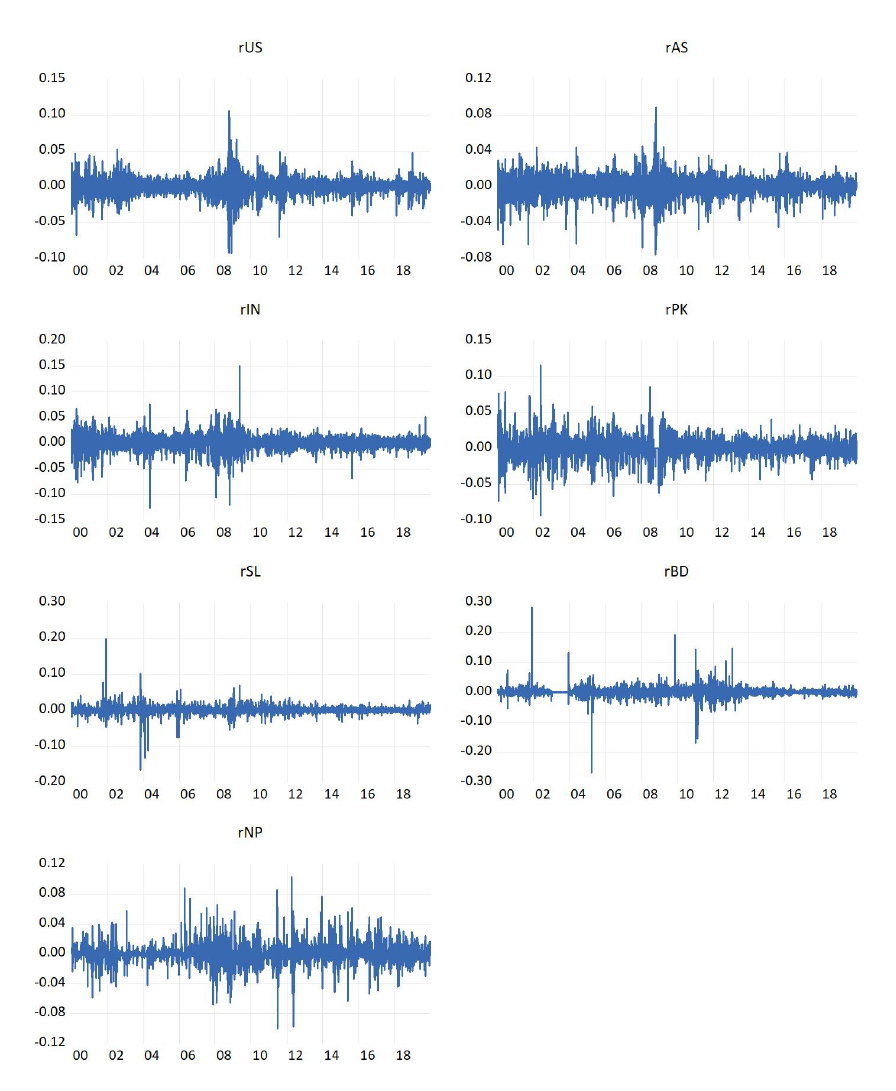
Figure 2. Equity returns. This graph shows the return on the aggregate equity market indices for the sample countries. rUS, rAS, rIN, rPK, rSL, rBD and rNP refer to the return on US, Asia, India, Pakistan, Sri Lanka, Bangladesh, and Nepal stock indices respectively. The sample period is from 4 January 2000 to 31 December 2019. In each graph, x-axis shows the time and y-axis shows the return. Data source: